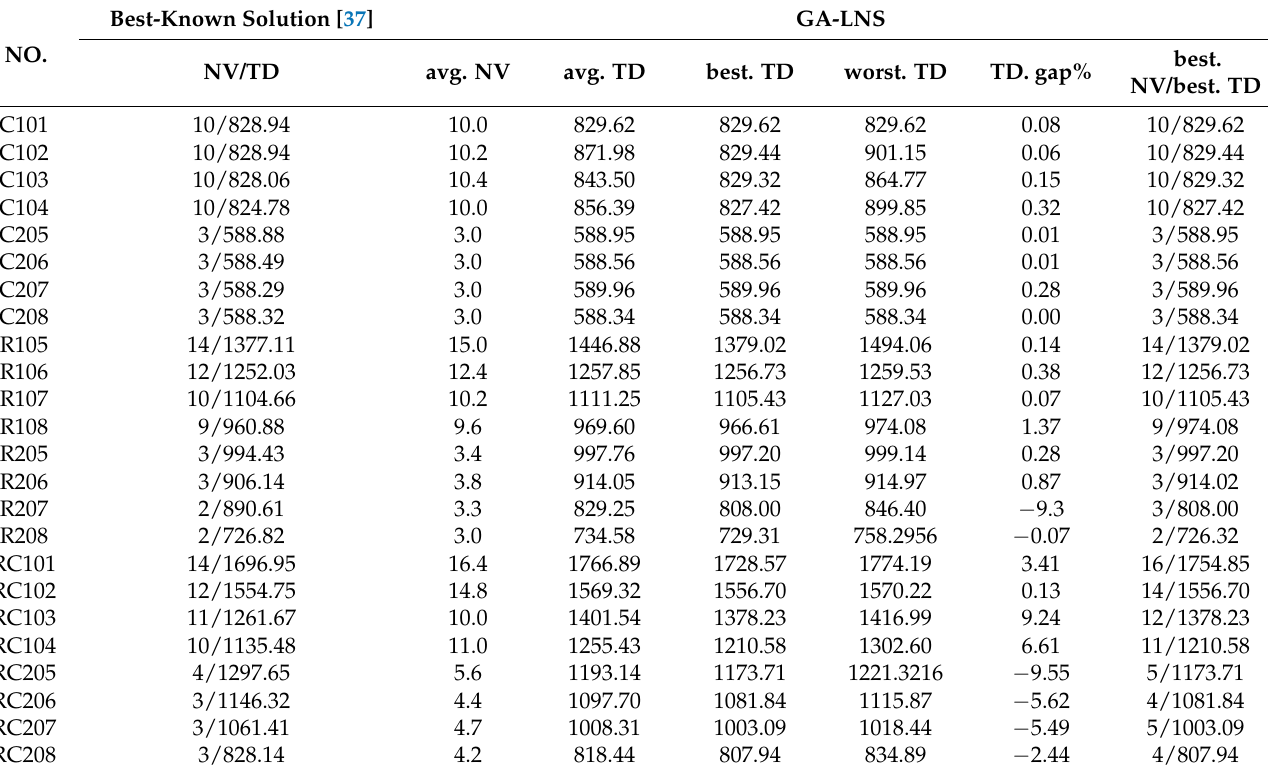
Table 5. The experimental results for the large-scale of Solomon’s instances with VRPTW model.